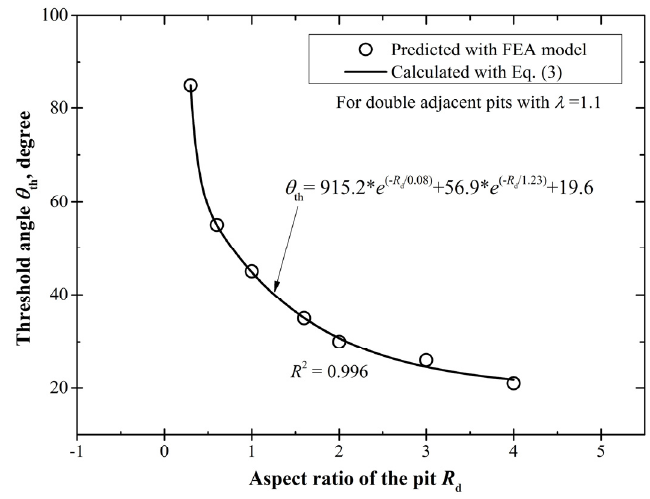
Figure 13. The relationship of the threshold angle θ th with the aspect ratio R d , reflecting the dependence of the affected spatial scope on the pit depth.